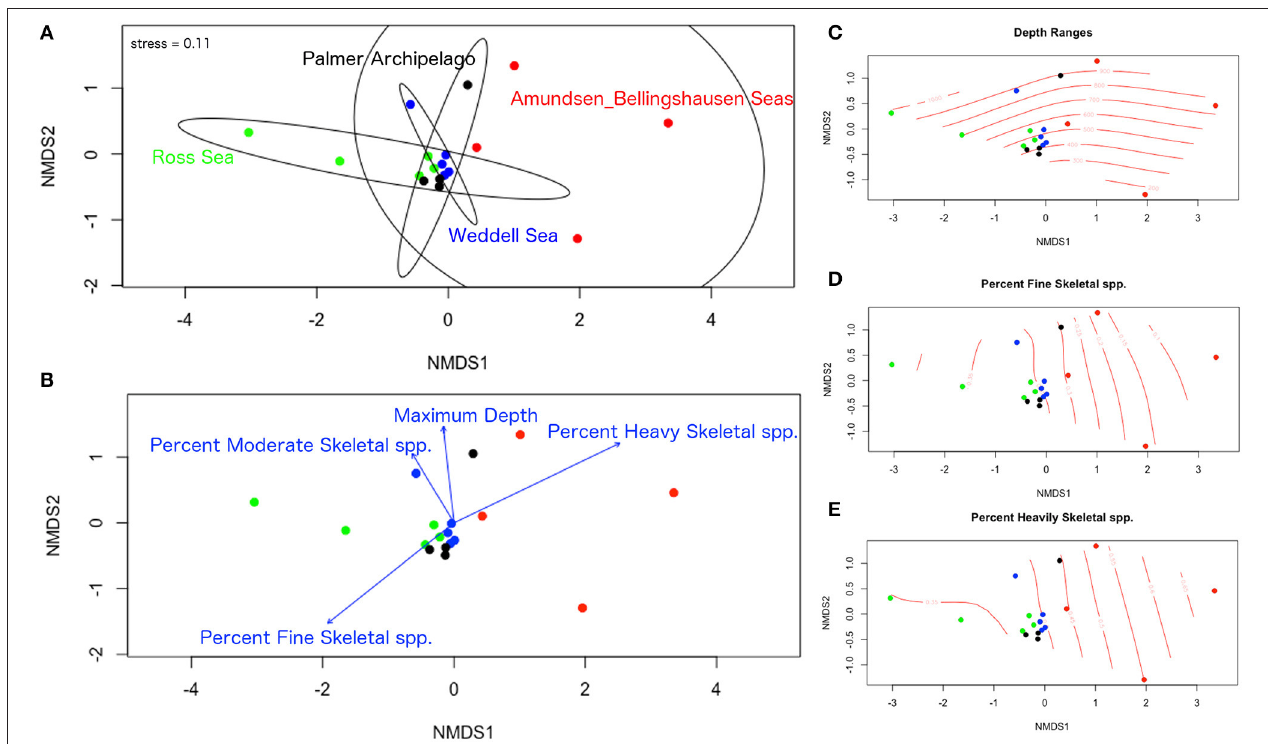
FIGURE 7 | Non-metric dimensional scaling analysis of bryozoan species records gathered from external datasets. (A) Ordination plot of all sites and depth ranges with 95% confidence ellipses around each region. (B) Ordination plot of all sites and depth ranges with environmental vectors for maximum depth, percent fine skeletal species, percent moderate skeletal species, and percent heavily skeletal species. (C–E) Ordinal surface plots for depth ranges, percent fine skeletal species, and percent heavily skeletal species. All percentages are listed as decimals.